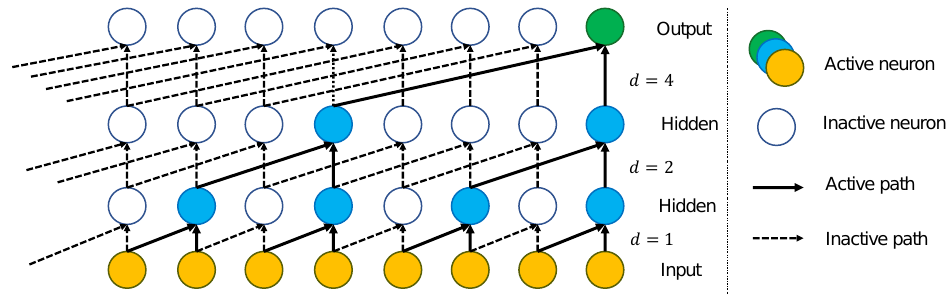
Figure 3. Dilated causal convolution in a TCN of four